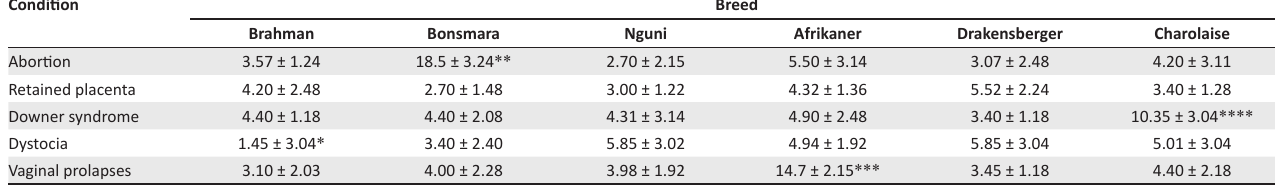
TABLE 4: Mean serum urea or blood urea nitrogen concentration in different cow breeds experiencing reproductive conditions.